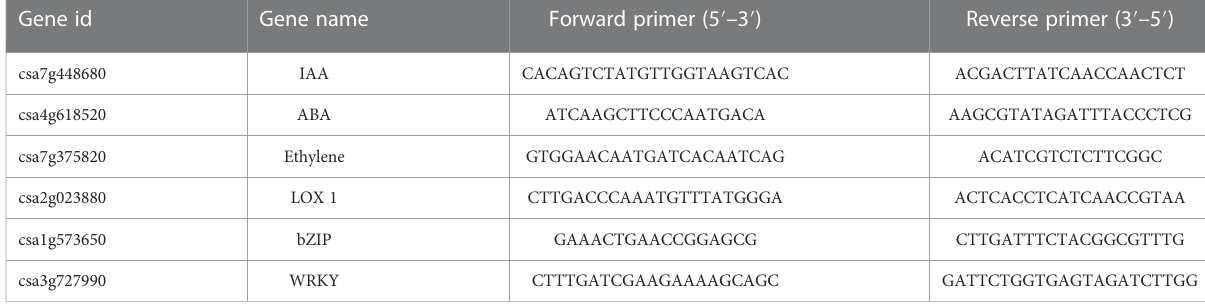
TABLE 1 Primers used for quantitative real-time PCR (qRT-PCR) analysis. Gene